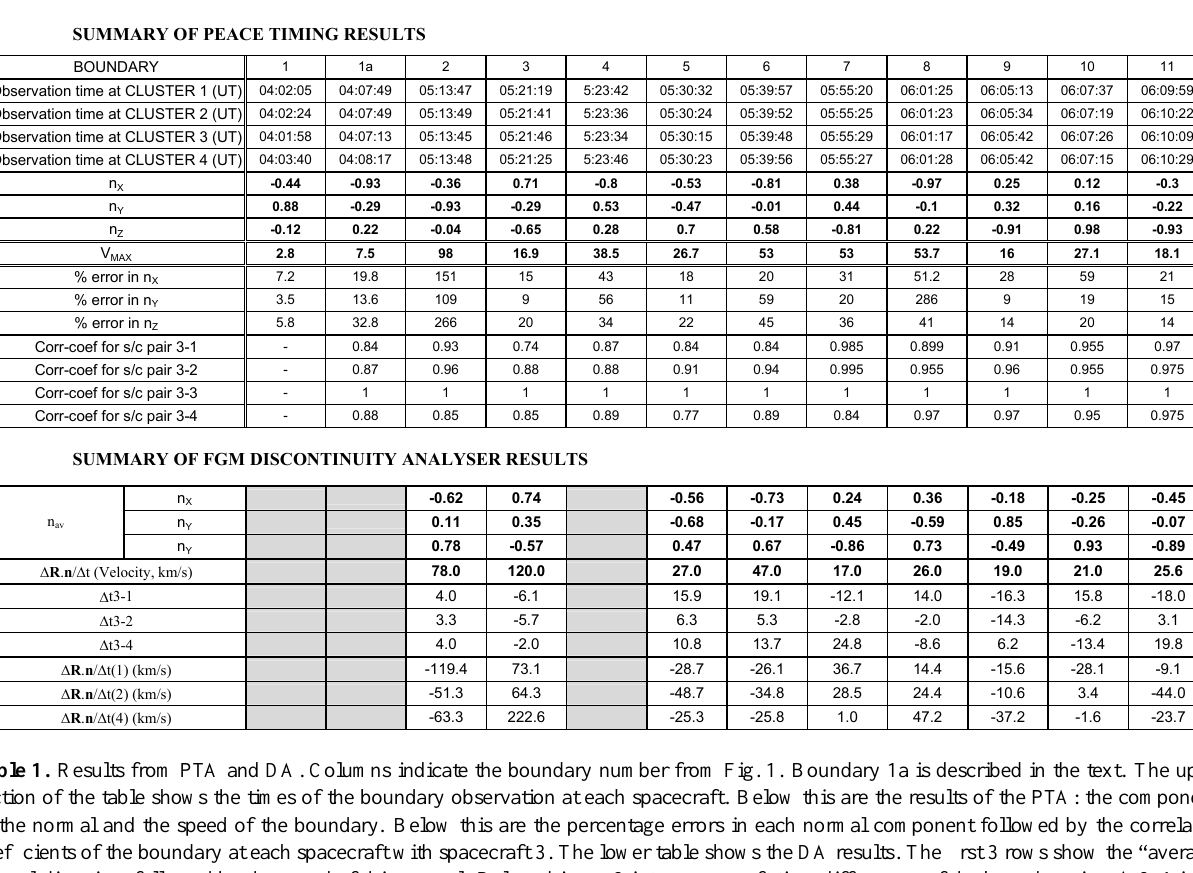
are no distinct lobe features in the plasma data, one